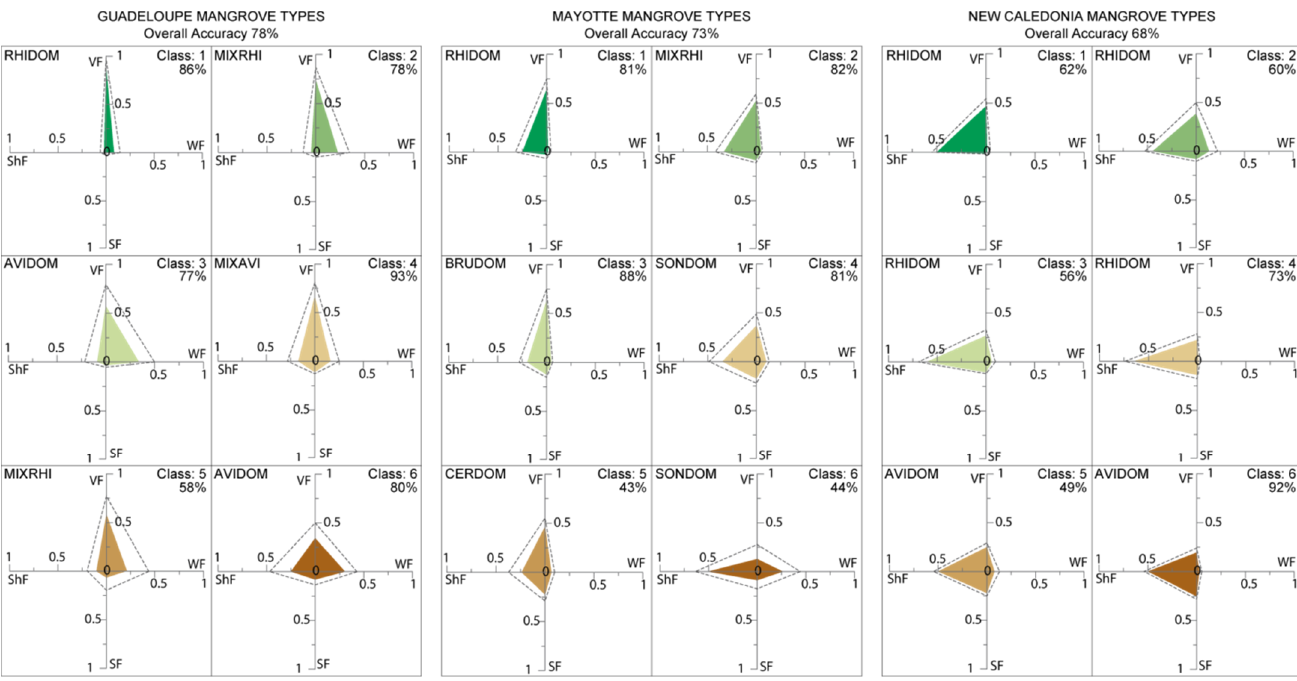
Figure 7. Component diagrams of the four fractions showing main mangrove vegetation structures. Coloured polygons: mean fractions for each class. Dotted line: standard deviation of the corresponding class. Percentage: user accuracy of the class.